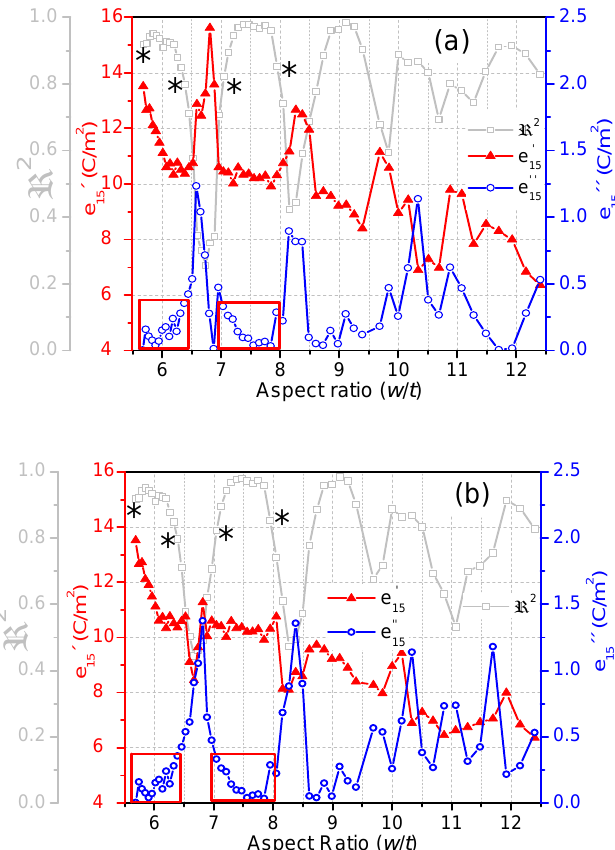
Figure 10. Evolution of the complex piezoelectric coefficient e 15 as a function of the aspect ratio of the BCZT plate; the real and the imaginary parts (e 15 ´ and e 15 ´´) are both plotted : ( a ) calculated by the automatic iterative method; ( b ) recalculated by the modified automatic iterative method. The evolution of R 2 is shown as a reference.